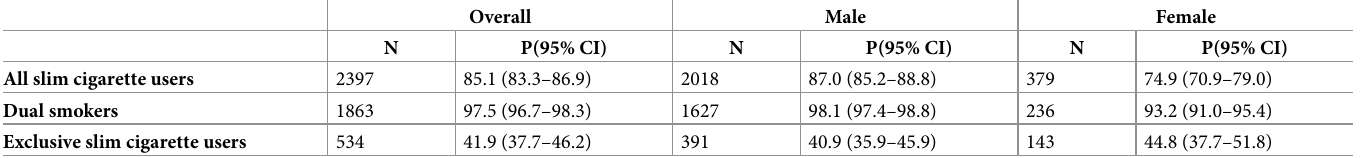
Table 3. Proportion of current slim cigarette smokers who initiated with regular